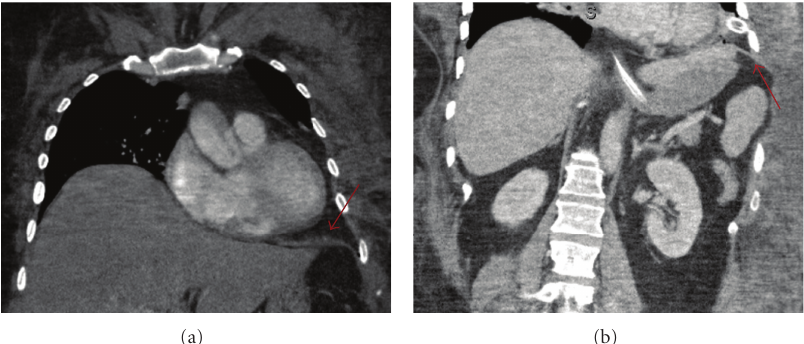
Figure 4: Coronal CT images of the chest and abdomen taken 1 week after surgical repair of the diaphragm (red arrow) show no residual transdiaphragmatic or intercostal